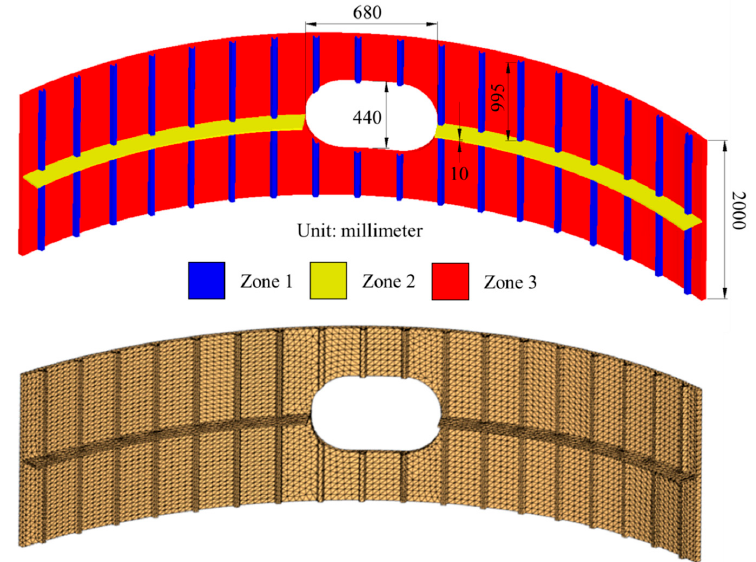
Figure 14. Fuselage section geometry and mesh.